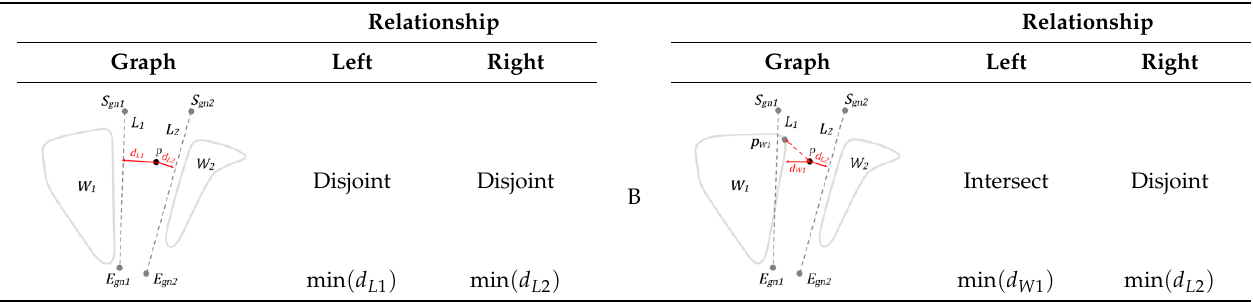
Table 2. Center point judgment method.